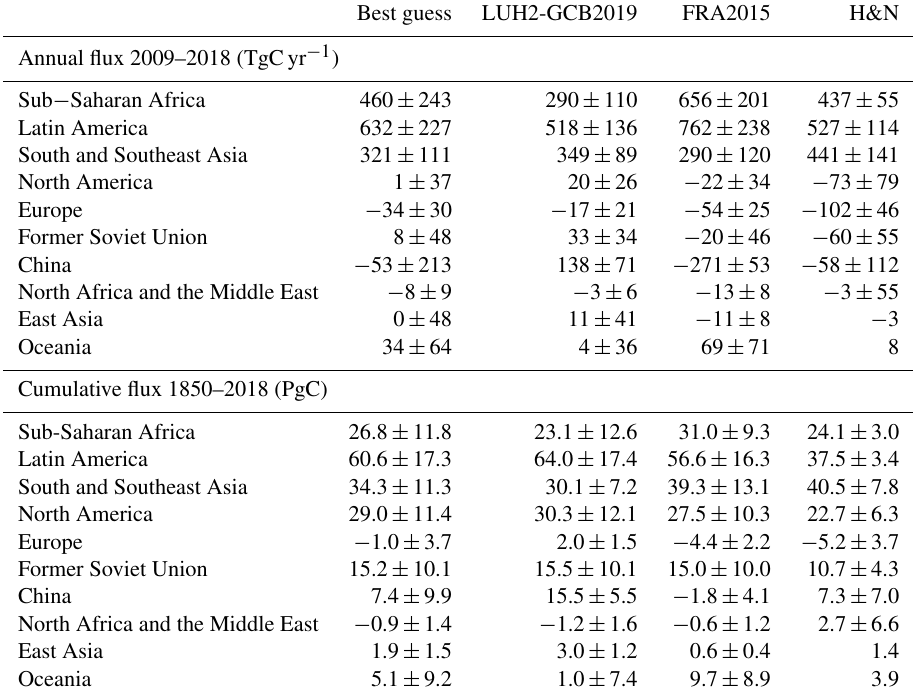
Table A3. Comparison of regional bookkeeping LULCC emissions with H&N estimates. H&N values are taken directly from Houghton and Nassikas (2017): their annual flux is calculated over the 2006–2015 period, and their cumulative flux is calculated over the 1850–2015 period.